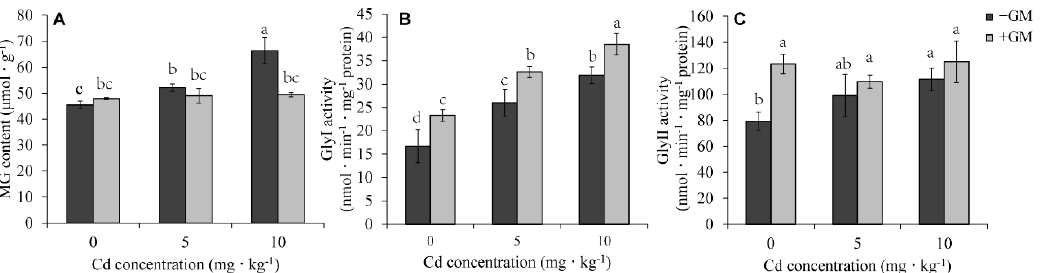
Figure 5. Effects of AMF on MG content ( A ) and its degradation-related enzyme Gly I and Gly II activities ( B , C ) under different Cd concentrations. Values are the means ± standard deviation (SD) ( n = 3). Different letters in the same column indicate statistically significant differences ( p < 0.05).